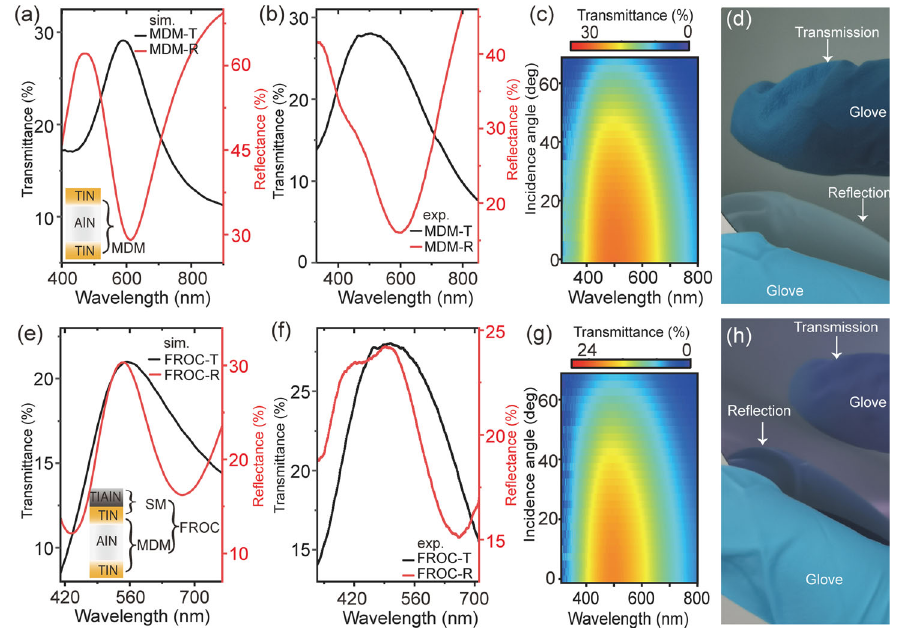
Fig. 5 Calculated ( a ) and measured ( b ) reflectance (red curve) as well as transmittance (black curve) spectra of a MDM film stack at normal incidence. Inset: Scheme of MDM film that is made of TiN-AlN-TiN from top to bottom. The thickness of film from the topmost to the bottom layer is TiN = 20 nm, AlN = 70 nm, and TiN = 20 nm, respectively. Calculated ( e ) and measured ( f ) reflectance (red curve) and transmittance (black curve) spectra of a FROC film at normal incidence. Inset: scheme of FROC film consisting of TiAlN-TiN-AlN-TiN. The thickness of each layer from top to bottom is TiAlN = 20 nm, TiN = 20 nm, AlN = 70 nm, and TiN = 20 nm, respectively. Measured transmittance spectra of a MDM film ( c ) and a FROC film ( g ) versus incidence angle. Photographs of a MDM and a FROC coating on glass. The coatings are semi-transparent. The reflection of a glove and transmission of another glove can be observed simultaneously. The MDM reflects and transmits different colors ( d ). The FROC, however, reflects and transmits nearly the same color ( h